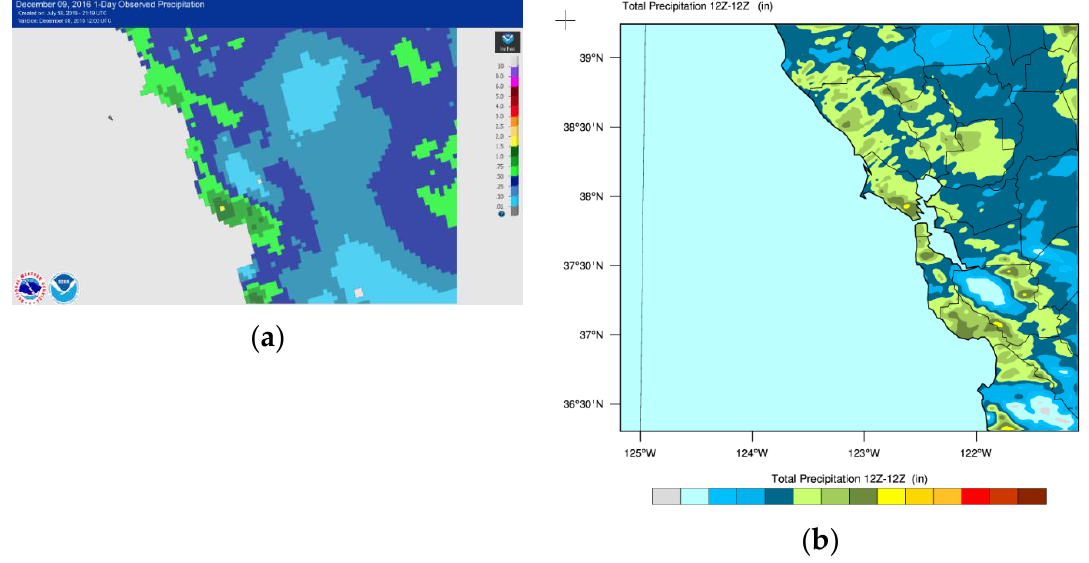
Figure 14. Observed (left, a ) and WRF-simulated (right, b ) accumulated for 12Z–12Z, 8–9 December 2016.